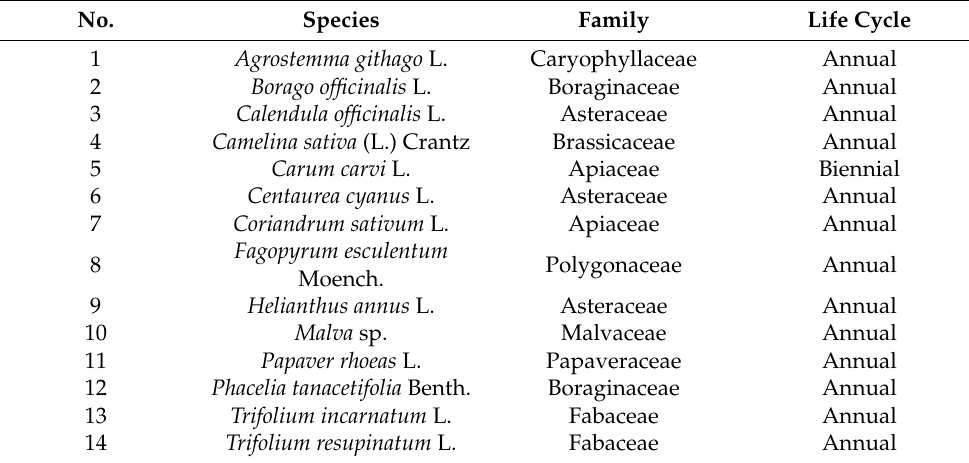
Figure 1. Location of the flower strip (red color) in relation to the field and location of the Wielkopolska National Park in Poland (source: WPN). Table 1. Species composition of the sown plant seed mix in the flower strip.